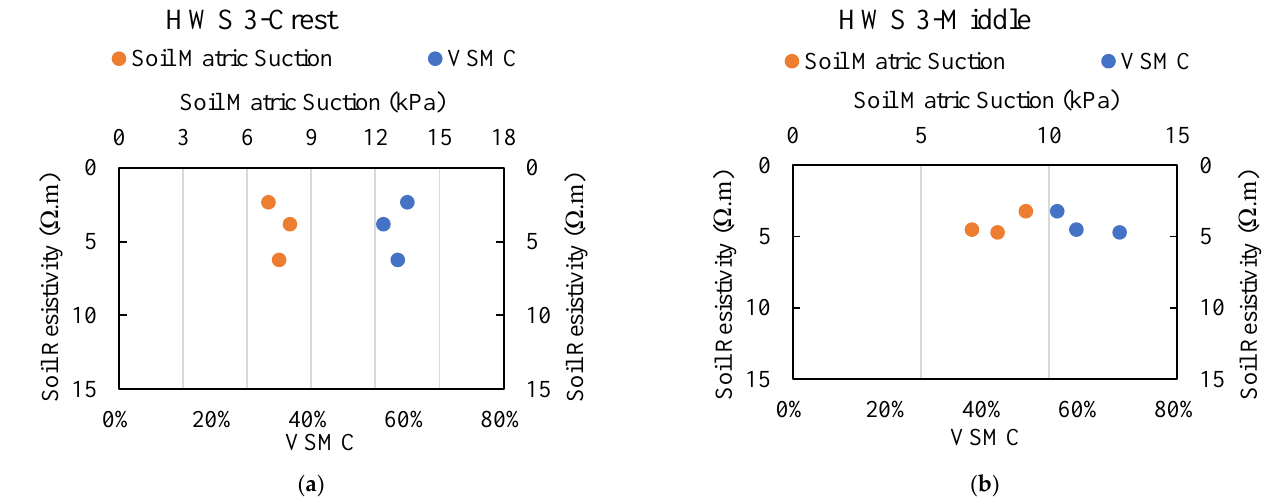
Figure 19. HWS 3 comparison of 2D ERI test profile with field instrumentation ( a ) At crest of the slope ( b ) At middle of the slope (1 m = 3.28 ft; 1 mm = 0.039 in; 1 kPa = 20.89 psf).